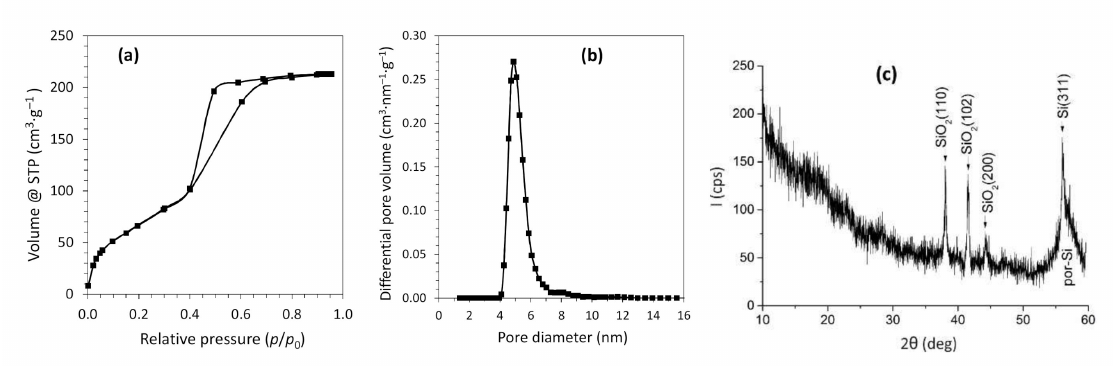
Figure 2. Isotherm of N 2 adsorption-desorption at 77 K ( a ), pore size distribution ( b ), and X-ray di ff ractogram ( c ) of the por-Si membrane.